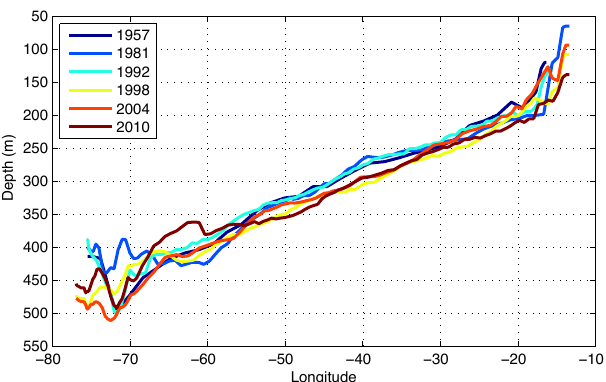
Fig. 10. Depth of the 17 ◦ C isotherm across the mid-ocean for the 1957, 1981, 1992, 1998, 2004 and 2010 hydrographic sections (fol- lowing Longworth, 2007). Values are smoothed using a ± 4 ◦ longi- tude running mean between 70 ◦ W and 20 ◦ W and a ± 1 ◦ window west and east of this at the ocean